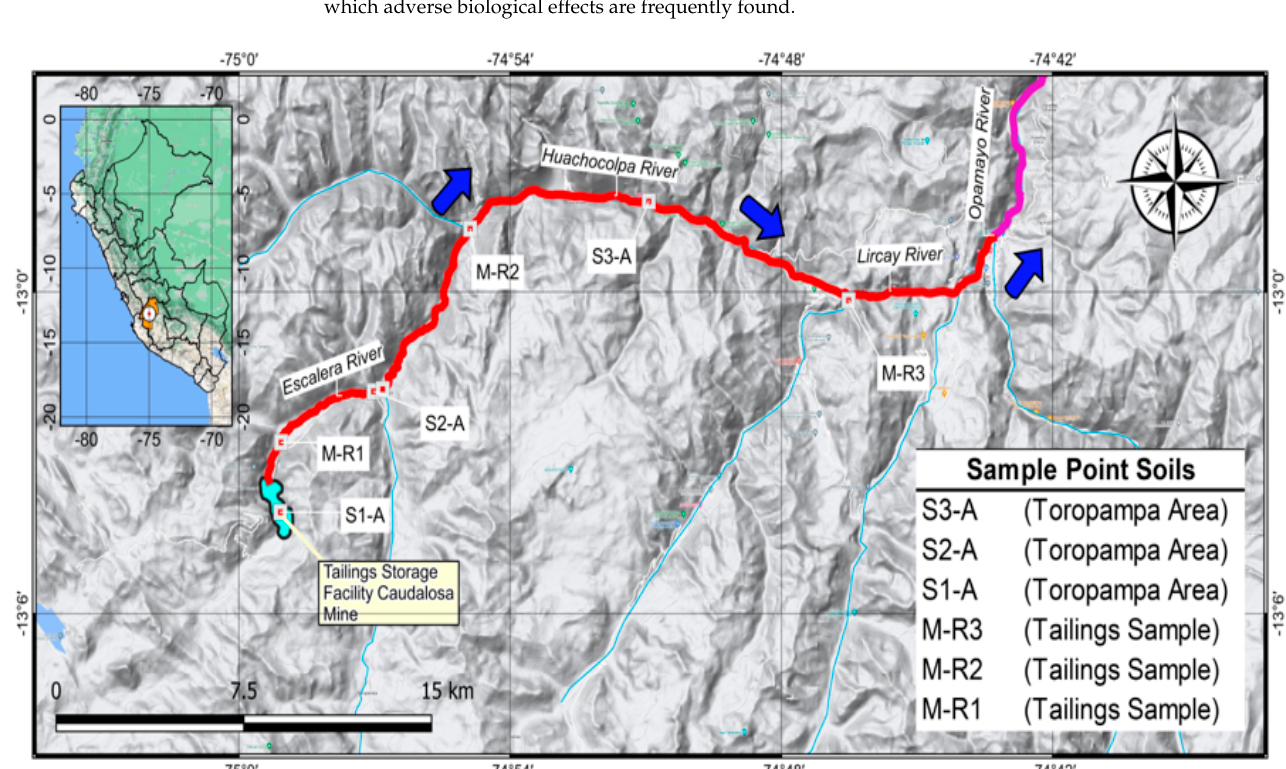
Figure 7. Monitoring Points in Tailings Spill Soils—Department of Huancavelica (Modified from [45]).